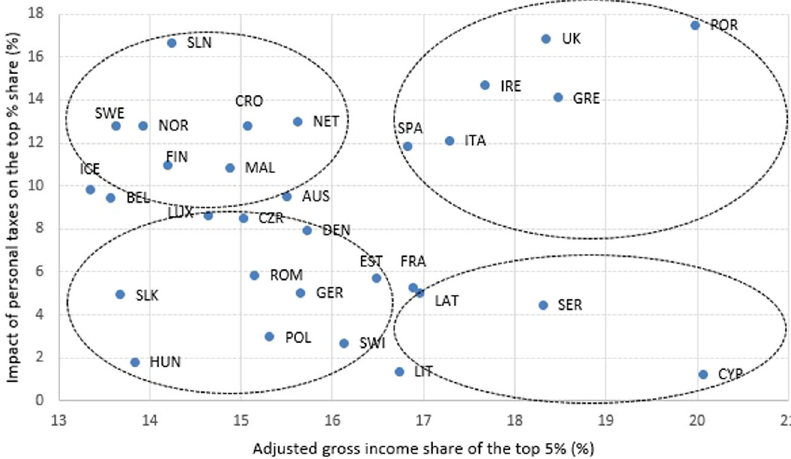
Fig. 4 Correlation between pre-tax income inequality and redistributive impact of taxes (top 5% shares), European countries (2013 – 2014) (%). Source: EU-SILC microdata 2014 and 2015.